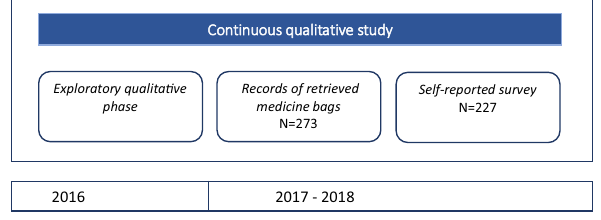
Figure 1. Flow chart of the study methodology and